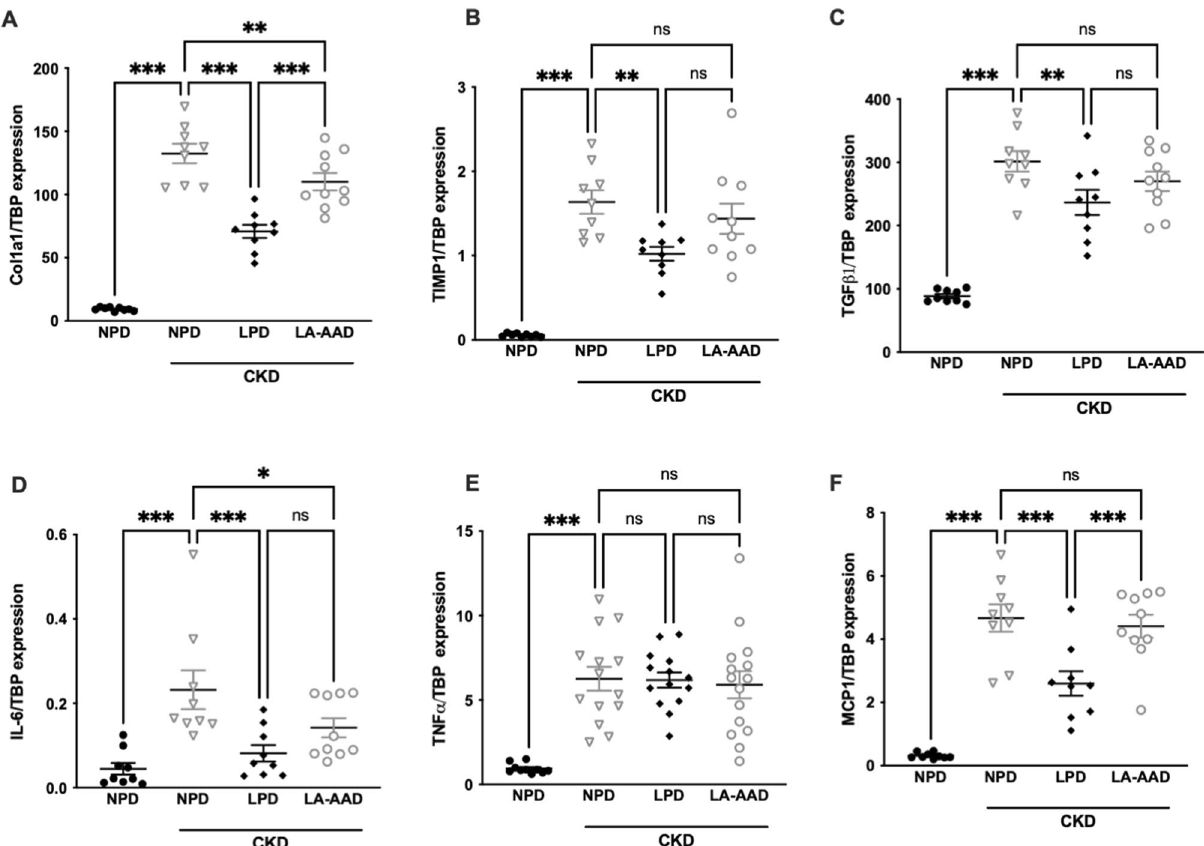
Figure 4. Gene expression of fibrosis and pro-inflammatory markers in kidney. Effects of normoproteic diet (NPD), low protein diet (LPD) and low aromatic amino-acid diet (LA-AAD) on relative mRNA expression of ( A ) Col1a1 (collagen alpha-1 type 1), ( B ) TIMP1 (Tissue Inhibitor of Metalloproteinase 1), ( C ) TGFβ1 (Transforming Growth Factor beta 1), ( D ) IL-6 (Interleukin 6), ( E ) TNFα (Tumor Necrosis Factor alpha) and ( F ) MCP-1 (Monocyte Chemoattractant protein 1) in control and CKD mice . TBP (TATA-Box Binding Protein) was used as reference gene to normalize the results. For gene expression, the relative fold gene expression level for each sample was calculated using the 2 −∆∆Ct method. Results are expressed as the ratio of target mRNA to TBP mRNA. Data are expressed as mean ± SEM for n = 9–10 animals in each group. * p < 0.05, ** p < 0.01, *** p < 0.001 versus CKD-NPD; (ANOVA and Dunnett post hoc test).